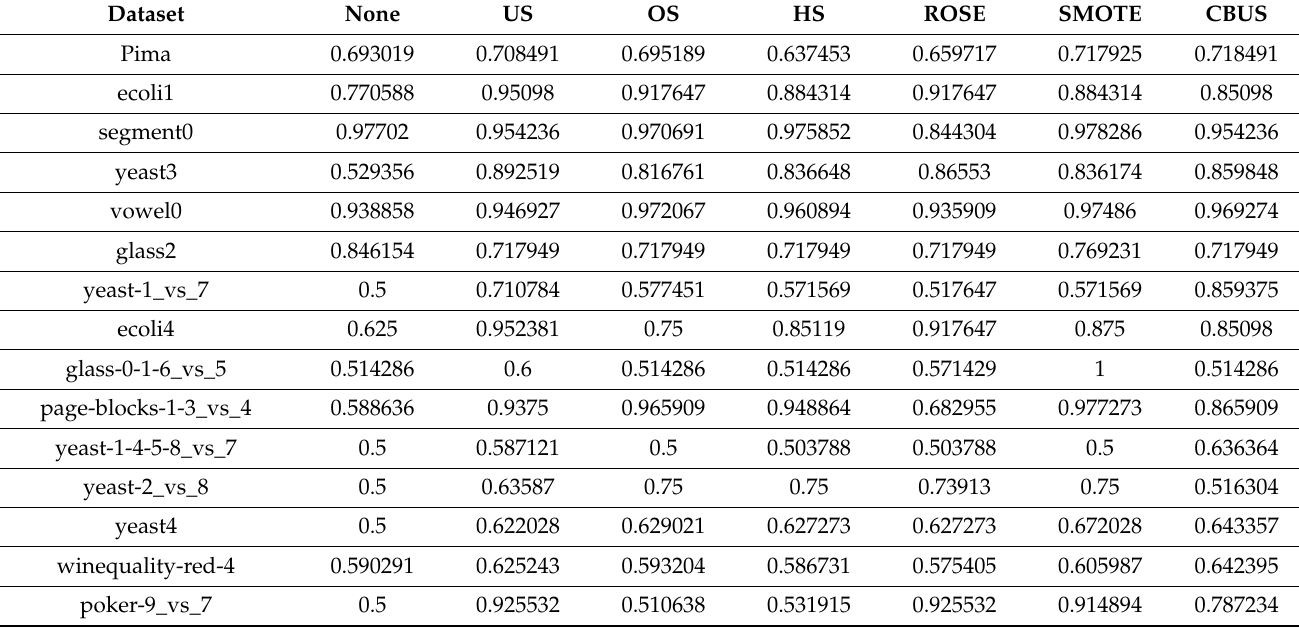
Table 5. Performance of DBT for NB